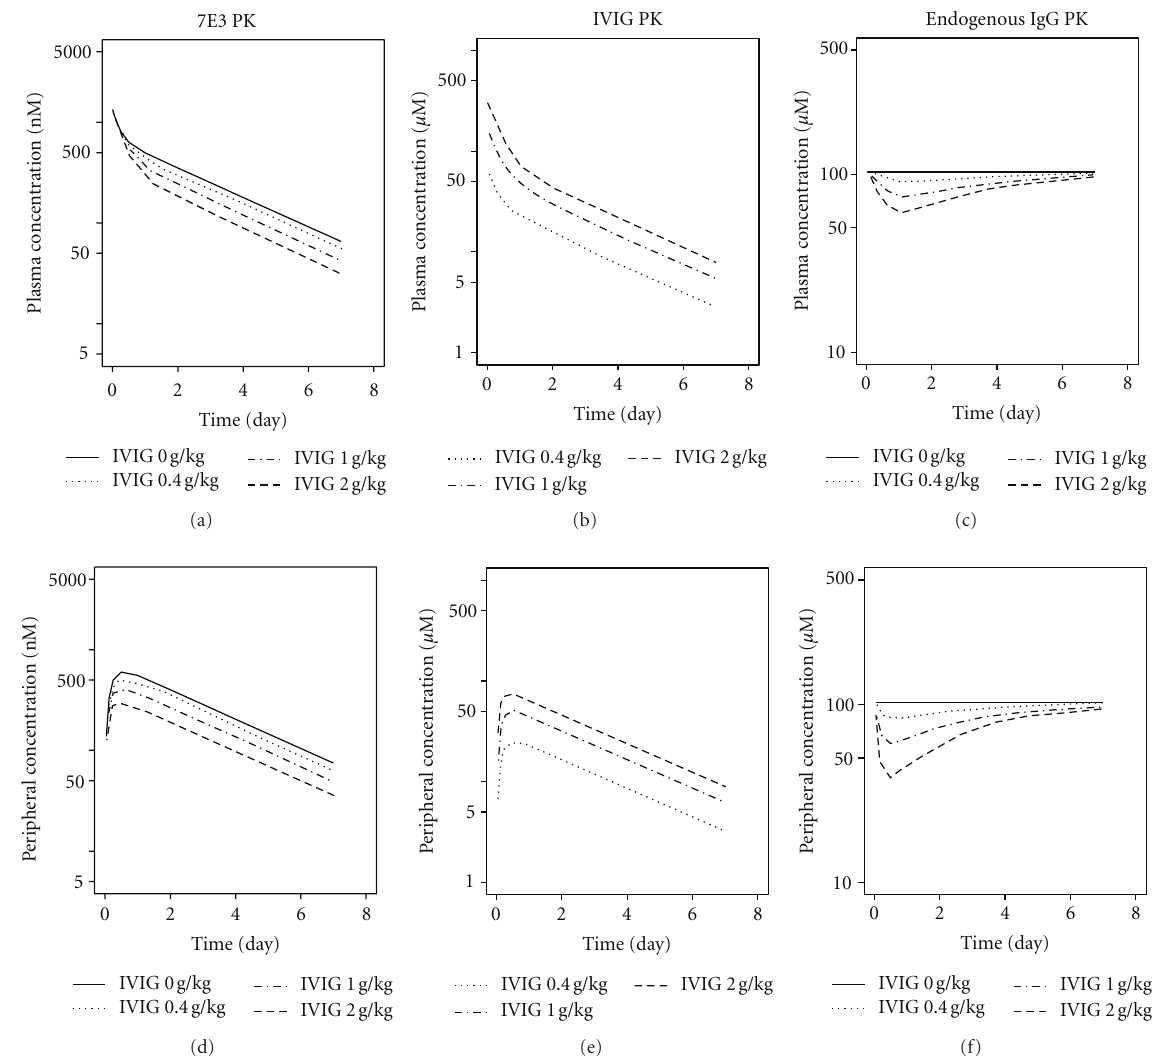
Figure 3: Simulated PK profiles using the rat cuto ff model. All rats receive 8mg/kg 7E3, as well as IVIG at indicated dose levels. Plasma and peripheral concentrations of 7E3, IVIG IgG, and endogenous IgG are